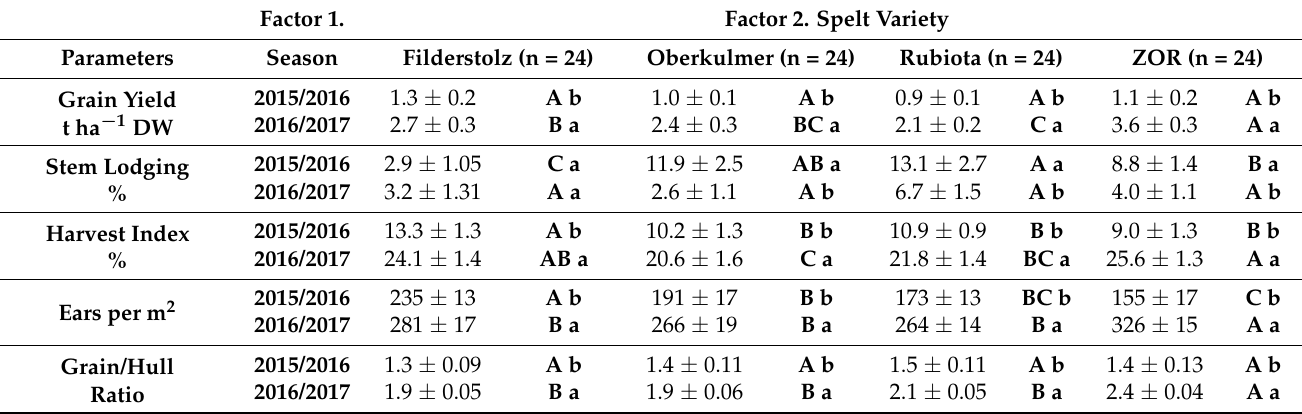
Table 5. Interaction means ± SE for the effects of growing season (2015/2016 and 2016/2017) and variety (Filderstolz, Oberkulmer, Rubiota and ZOR) on spelt wheat grain yield, yield-related growth parameters,). Factor 1.